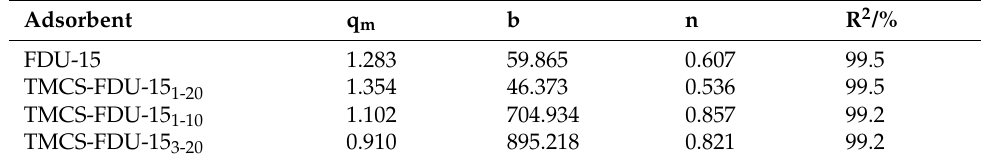
Table 3. Fitting results of Nap adsorption isotherms on FDU-15 and modified FDU-15.